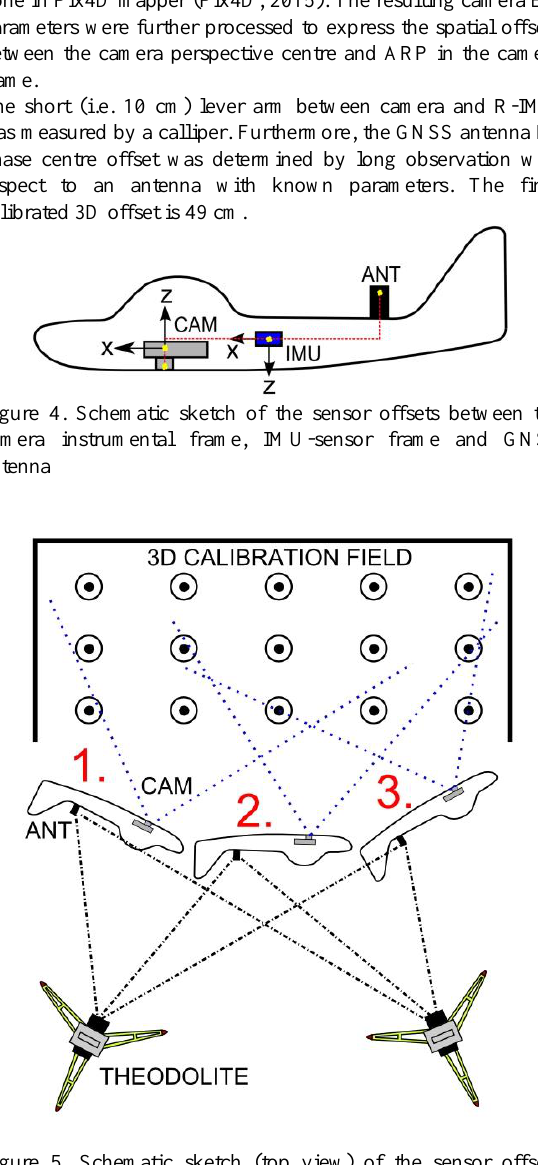
Figure 5. Schematic sketch (top view) of the sensor offsets calibration procedure; offsets measured from three